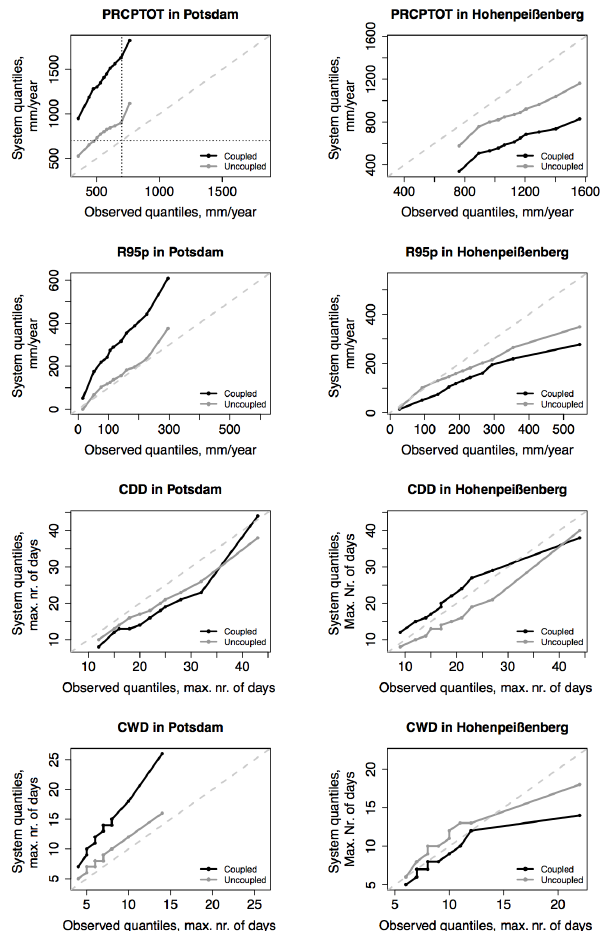
Figure 17. Quantile–quantile plots of the extreme indices shown in Fig. 16. The diagonal represents the perfect